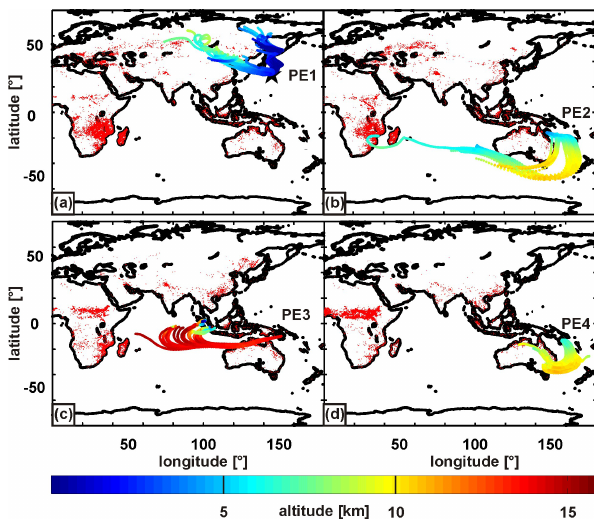
Fig. 7. HYSPLIT backward ensemble (120h) and single (315h) tra- jectories calculated at one representative altitude for the four char- acteristic locations; (a) PE1, (b) PE2, (c) PE3, and (d) PE4. The altitude of the trajectories is expressed by the color bar. MODIS fire counts (red dots) are displayed to picture the impact of biomass